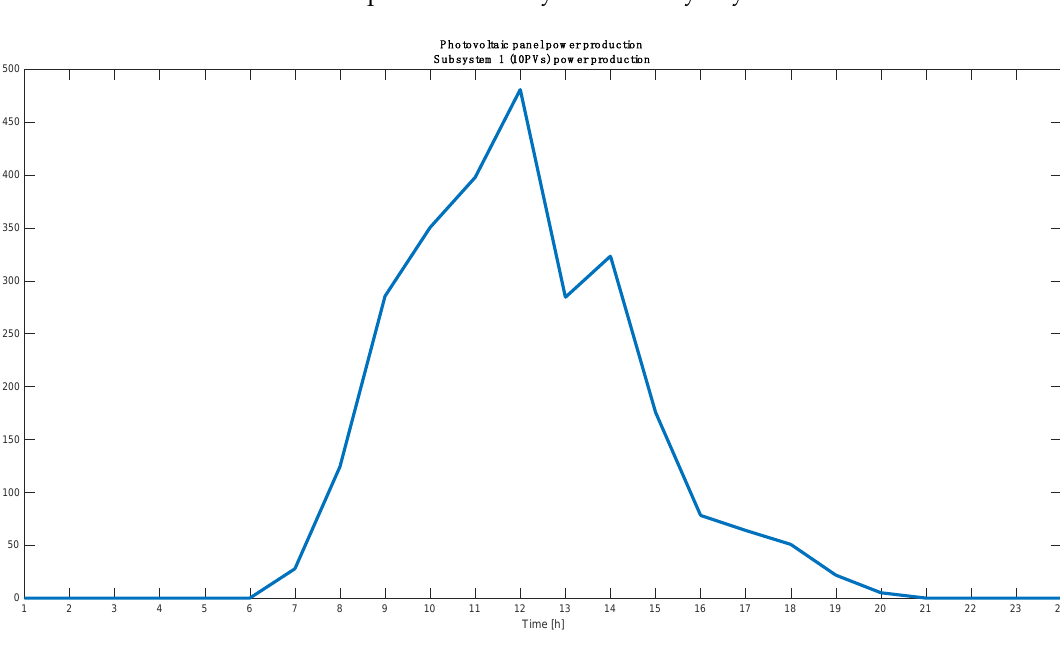
Figure 11. Subsystem 1: 10 PVs generation.